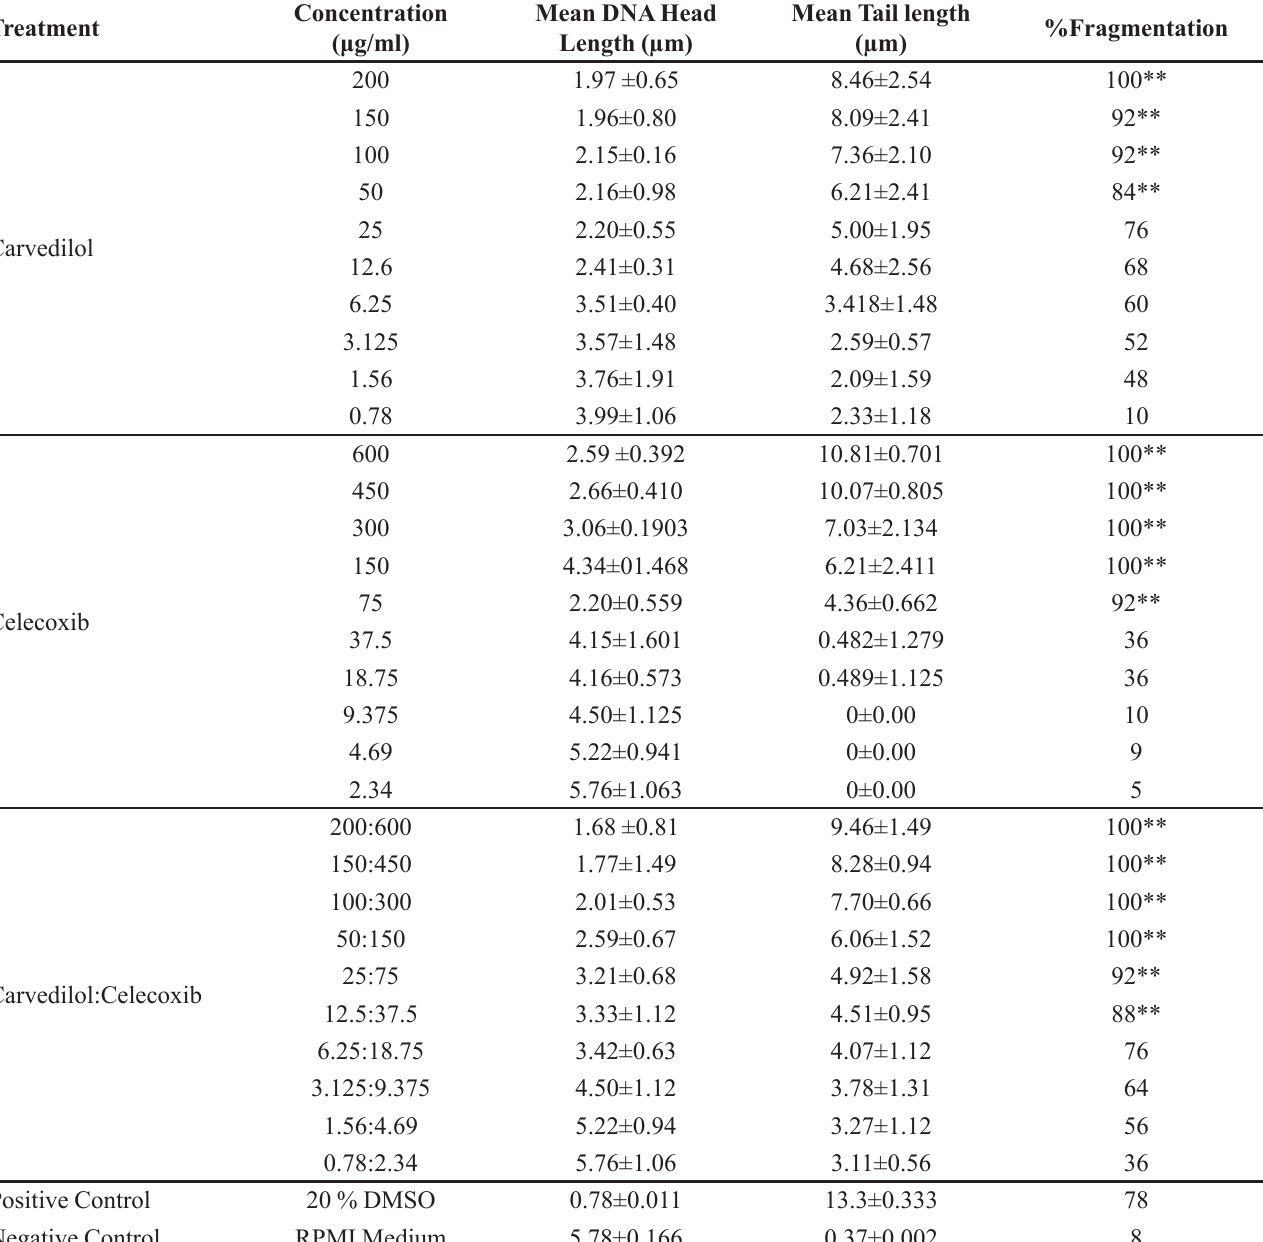
TABLE II - Percentage fragmentations of DNAs in the peripheral blood mononuclear cells (PBMCs) measured by single cell gel electrophoresis (comet assay) after 3 h incubation with various concentrations of Carvedilol, Celecoxib and their combination compared to respective